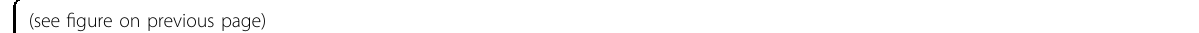
Fig. 1 IFN signaling and therapy during infection with novel SARS-CoV-2 variant Omicron. a Caco-2 and Calu-3 cells were infected with SARS- CoV-2 variant Delta (GenBank ID: MZ315141), Omicron 1 (GenBank ID: OL800702), and Omicron 2 (GenBank ID: OL800703) at an MOI of 1. The infectious titer was determined 24 h post infection. Graphs represent means ± SD of three biological replicates. Statistically signi fi cant differences were identi fi ed by one-way ANOVA and subsequent Dunnett ’ s test. b Immunoblot analysis of total and phosphorylated STAT1 in SARS-CoV-2- infected Caco-2 (left panel) and Calu-3 (right panel) cells 24 h post infection. The protein levels were quanti fi ed by ImageJ. Graphs represent means ± SD of three biological replicates. P values were calculated using Student ’ s t test. c A549-ACE2/TMPRSS2 MDA5/RIG-I-WT (wt), A549-ACE2/TMPRSS2 MDA5 KO (MDA5 KO), and A549-ACE2/TMPRSS2 RIG-I KO (RIG-I KO) cells were infected with Delta, Omicron 1, and Omicron 2 variants at an MOI of 0.01 for 72 h. The number of infected cells was determined by immuno fl uorescence staining. Graphs represent data of four biological replicates. Statistically signi fi cant differences were identi fi ed by one-way ANOVA and subsequent Dunnett ’ s test. d Production of IFN α / β was measured by incubating supernatants from wt, MDA5-KO, and RIG-I KO cells infected with SARS-CoV-2 variants at an MOI of 0.01 for 48 h using HEK-Blue IFN α / β reporter cells. Graphs displays means ± SD of three biological replicates. Statistically signi fi cant differences were identi fi ed by one-way ANOVA and subsequent Dunnett ’ s test. e Dose – response curves of IFN α , IFN β , and IFN γ were determined in Caco-2 and Calu-3 cells. All IFNs were added to con fl uent monolayers and subsequently infected with viral variants at an MOI of 0.01. The inhibition rate was evaluated 24 h (Caco-2) and 48 h (Calu- 3) post infection by staining for the spike protein. Graphs depict means ± SD of three biological replicates. f Antiviral effect of IFN β in combination with nirmatrelvir, remdesivir, or EIDD-1931 in Caco-2 cells. Statistically signi fi cant differences were identi fi ed by one-way ANOVA and subsequent Dunnett ’ s test. g Heatmap of combination indexes (CIs) for IC 50 , IC 75 , IC 90 , and IC 95 . h Dots depict weighted average (CI wt ) calculated according to the formula: CI wt = (CI 50 + 2CI 75 + 3CI 90 + 4CI 95 )/10. CI wt < 1 synergism, CI wt = 1 additive effects, CI wt > 1